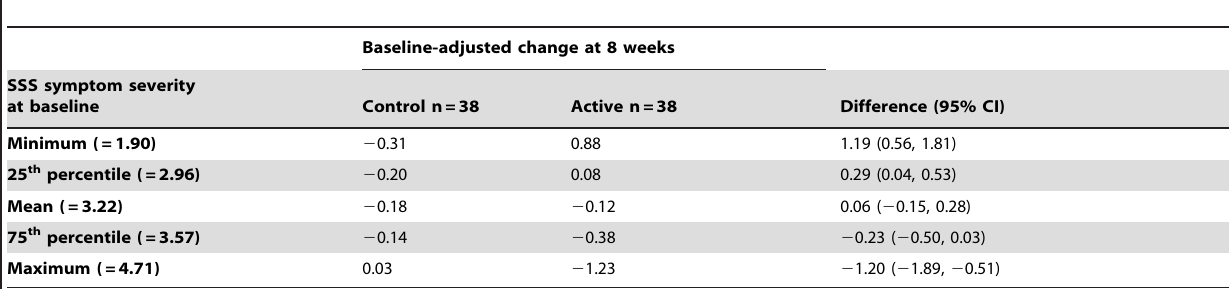
Table 3. Predicted values of the primary outcome, change in SSS symptom severity score at eight weeks, at varying levels of baseline SSS symptom